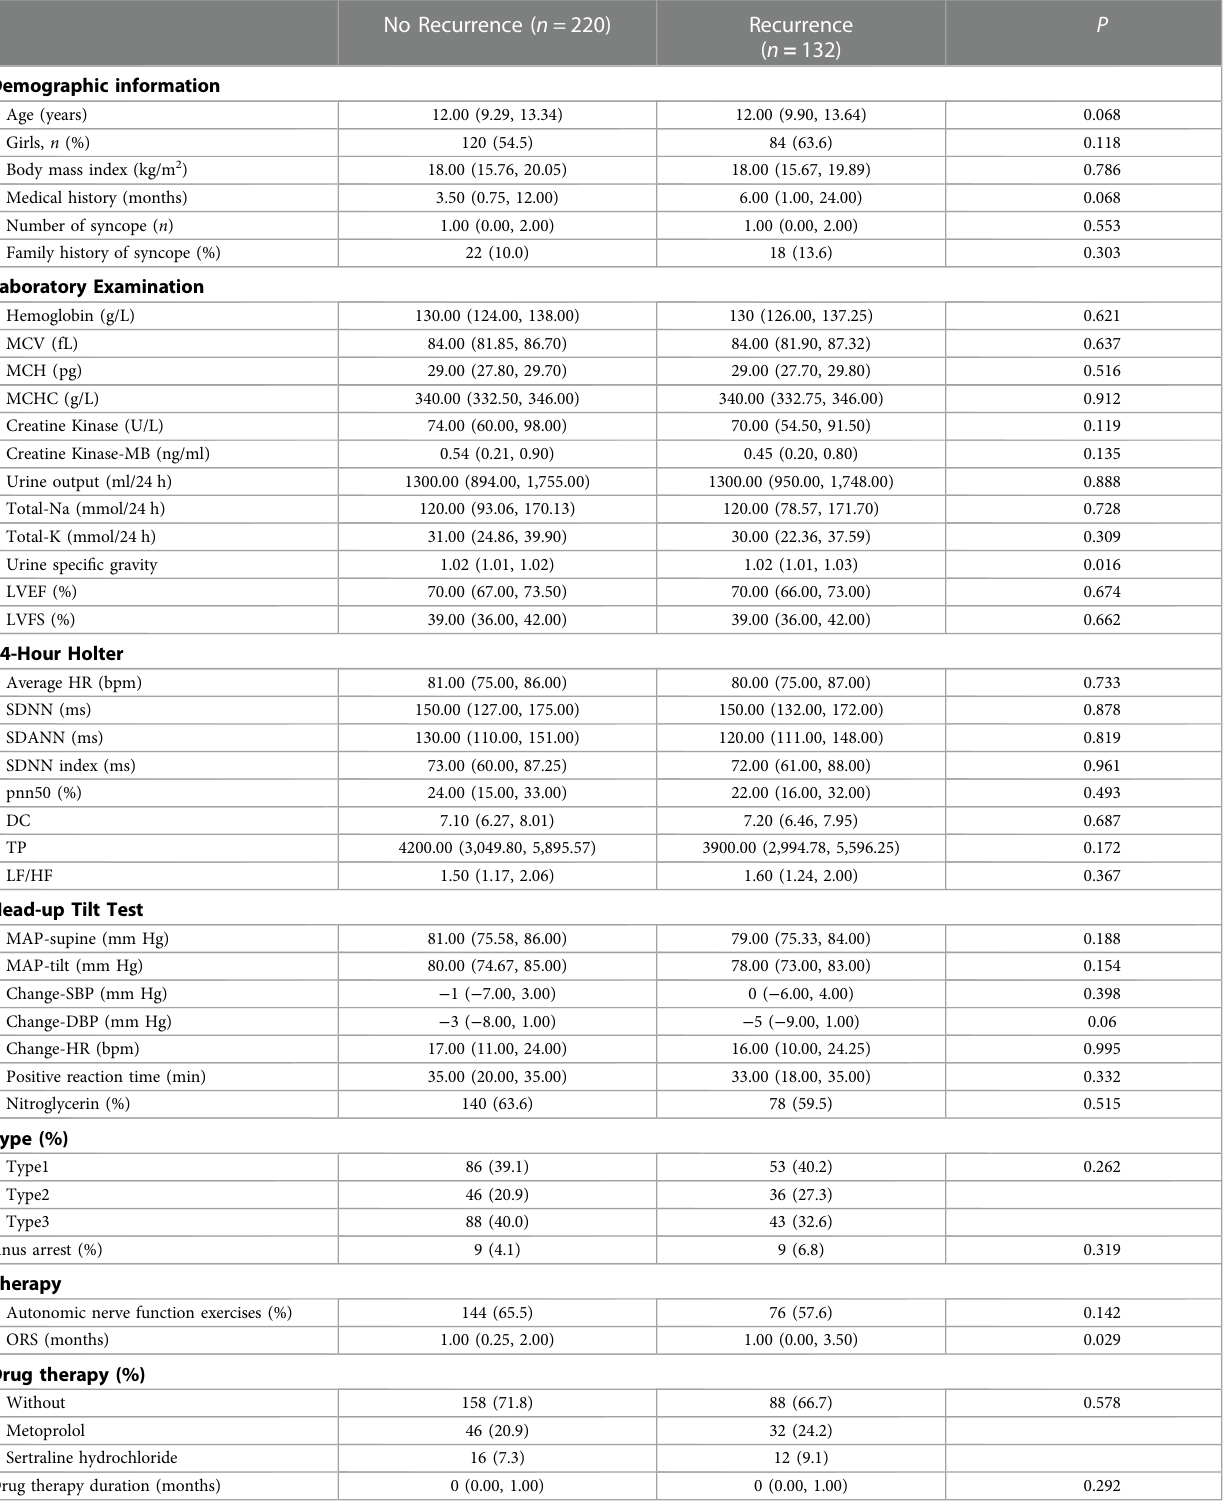
TABLE 1 Baseline characteristics of participating children by the presence and absence of recurrence of vasovagal